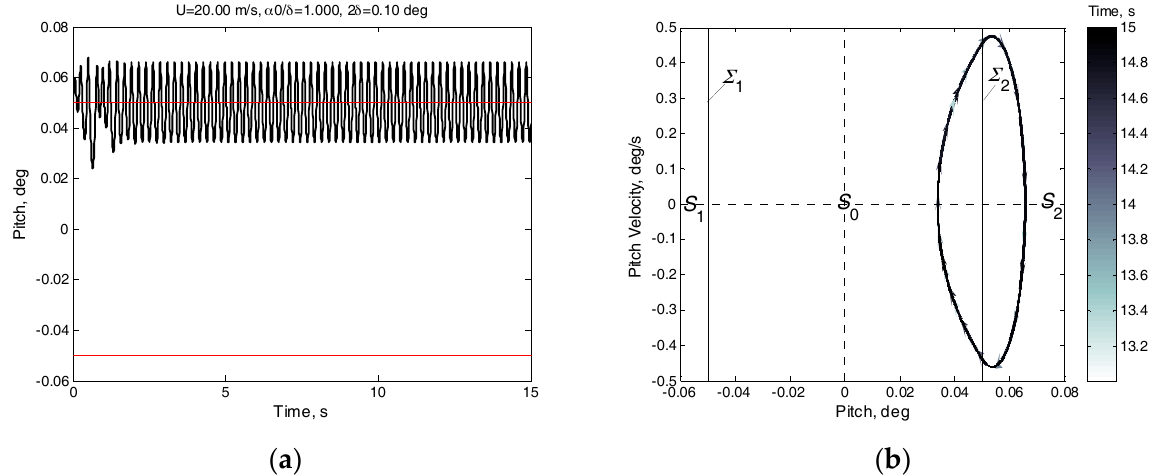
Figure 14. A two-domain LCO (2-D LCO) emerges when the flow velocity is 20 m/s and the initial non-dimensional pitch angle is 1.00, where the response of the freeplay state is presented by ( a ) a time history of 0–15 s and ( b ) a phase trajectory of 13–15 s.